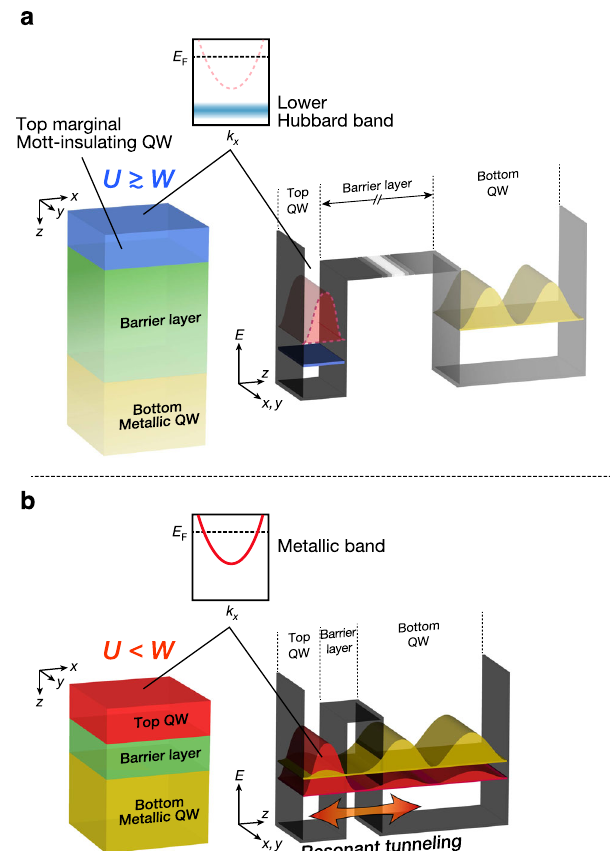
Fig. 1 Schematic illustration of the metal – insulator transition induced by resonant tunneling effects. a Before switching on the RT effect. The structure of a double QW consists of a marginal Mott-insulator QW layer/barrier layer/metallic QW layer. The marginal Mott-insulator ( U ≳ W ), which undergoes the transition to metal by application of a perturbation, is used as the top QW layer. Owing to the long distance between the top and bottom QWs, there is no RT effect between the two QWs. The corresponding band diagram and standing waves are illustrated on the right side. The potential well is represented as a black plate, while the existence-probability amplitudes of the metallic QW states are drawn in red for the top QW and in yellow for the bottom QW. Owing to the marginal Mott insulating nature of top QW states, the strongly correlated electrons in the original top QW states become localized, resulting in a localized state (lower Hubbard band) presented in blue. b After switching on the RT effect. Owing to the hybridization between the top and bottom QW states, bonding (red curve) and antibonding (yellow curve) states are formed. In this situation, electrons in the top QW will be able to move to the bottom QW via RT. By gaining the spatial degree of freedom, the effective Coulomb repulsion of electrons is weakened and the top QW undergoes the transition from the marginal Mott insulator ( U ≳ W ) to the metal ( U < W